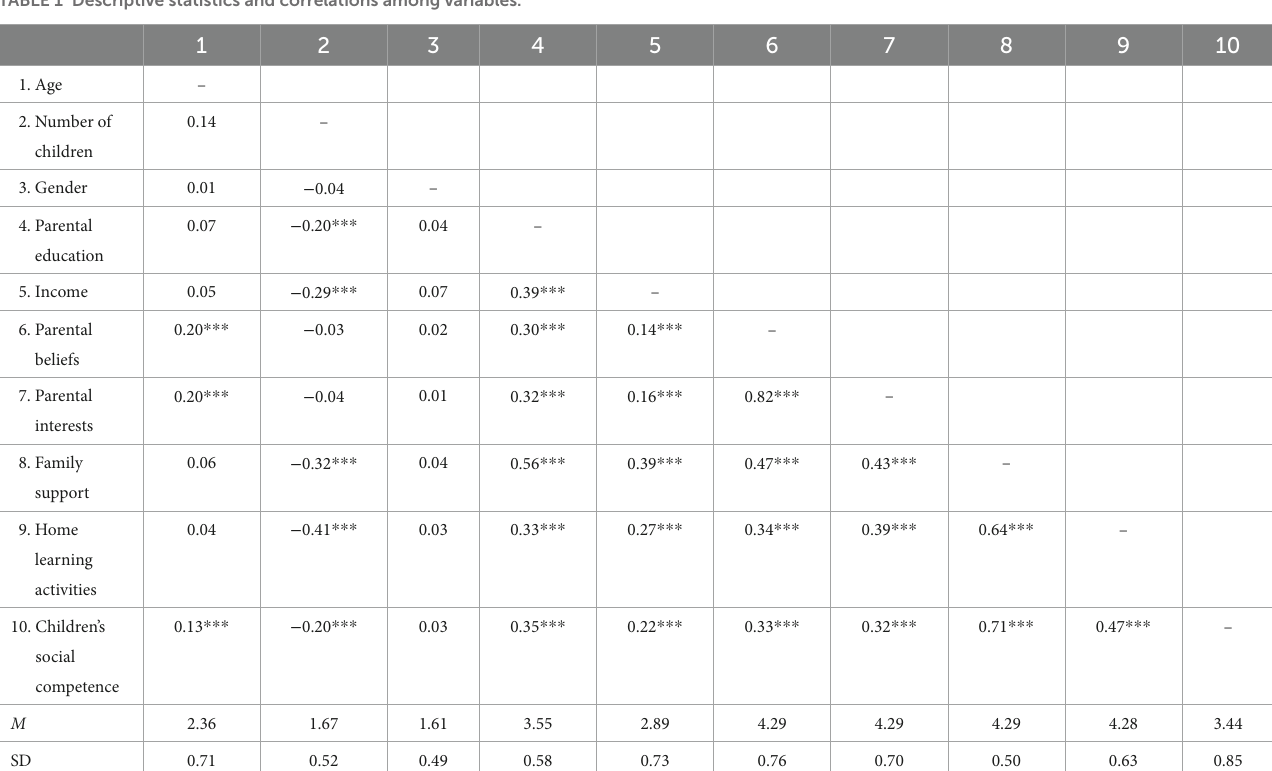
TABLE 1 Descriptive statistics and correlations among